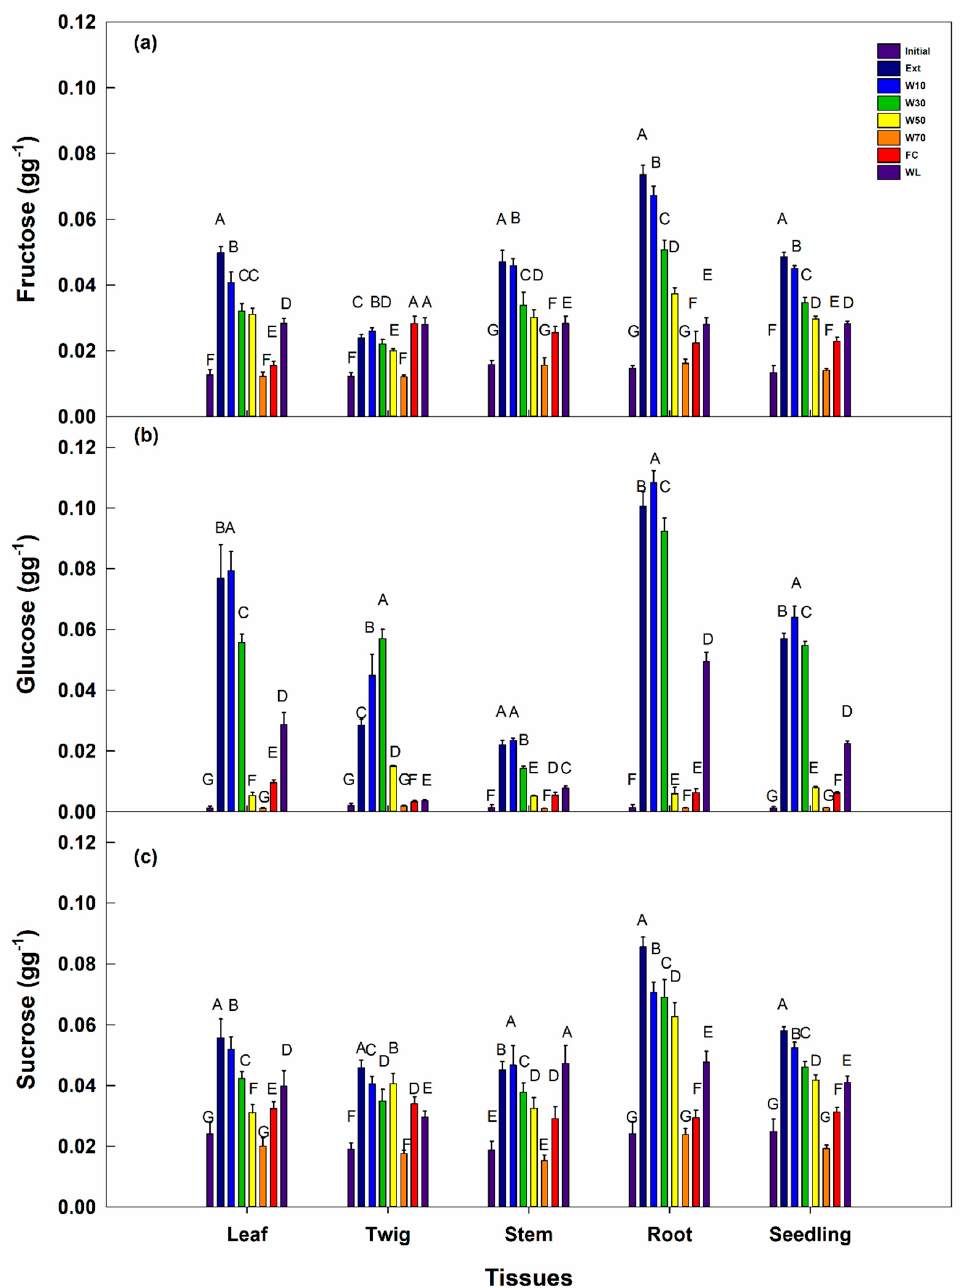
Figure 5. The mean concentrations of fructose ( a ), glucose ( b ) and sucrose ( c ) at the end of the 10-day water status treatments in 2015 and 2016. Values were back-transformed averages, and error bars represent standard errors for fructose, glucose and sucrose. The treatments are Ext: extreme drought, W10: 10% of field capacity (FC), W30: 30% of FC, W50: 50% of FC, W70: 70% of FC, and WL: permanently waterlogged. Asterisks indicate a significantly different value (*, p < 0.05; **, p < 0.01; ***, p < 0.001) between 2015 and 2016. Different letters indicate significant differences between treatments in each year. Note that the scale used for glucose is different from the scale used for fructose and sucrose.